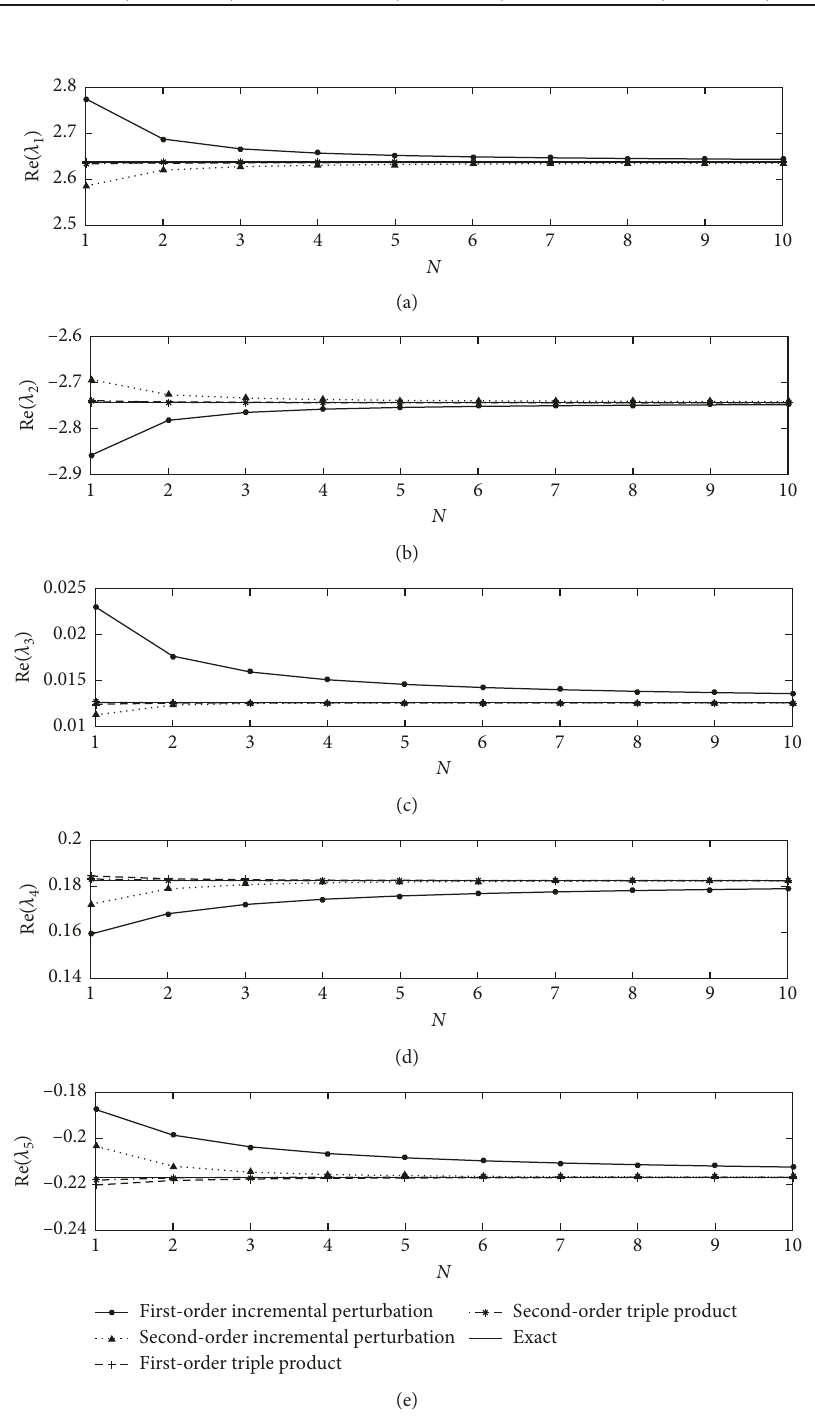
Figure 14: The real parts of the approximate eigenvalues of the whirling beam as a function of N for σ